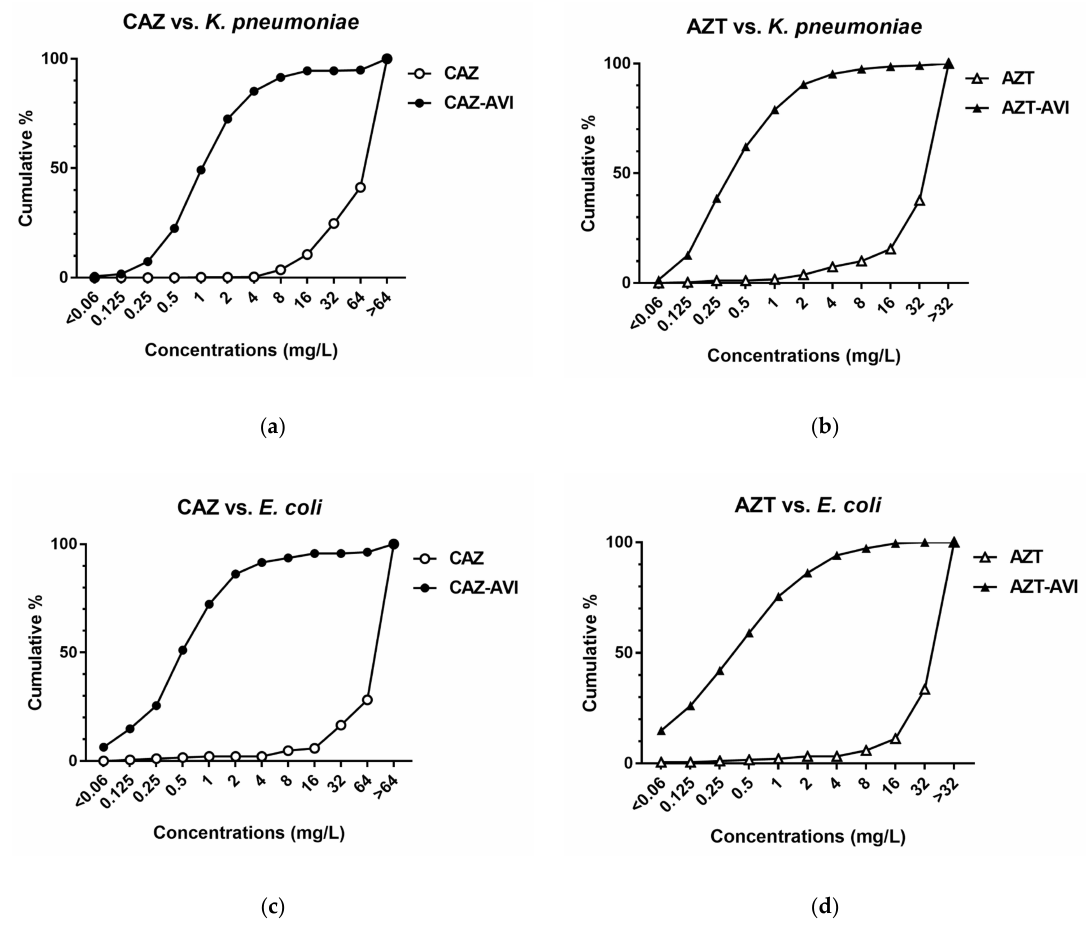
Figure 3. Cumulative MIC susceptibility curves against 472 CnsKP (a,b) and 188 CnsEC isolates (c,d). Data shown are for ceftazidime ( a , c ) and aztreonam ( b , d ). Abbreviations: CAZ, ceftazidime; CAZ-AVI, ceftazidime with avibactam; AZT, aztreonam; AZT-AVI, aztreonam with avibactam.